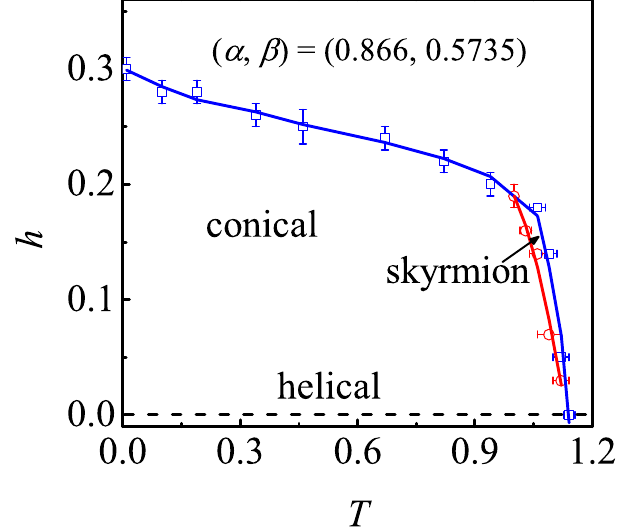
Figure 5. The estimated phase diagram in the ( T , h ) plane for ( α , β ) = (0.866,